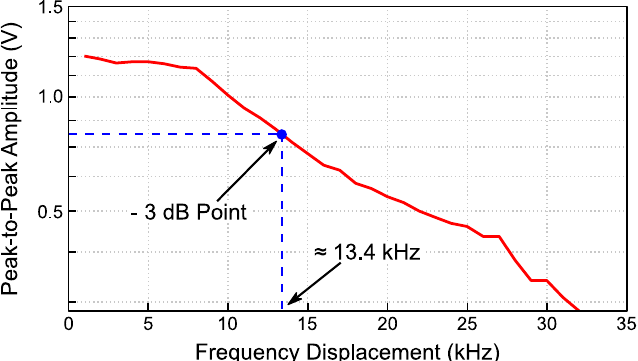
Figure 17. Peak-to-peak voltage of the output waveform provided by the detector as a function of the frequency spacing Δ𝑓 .